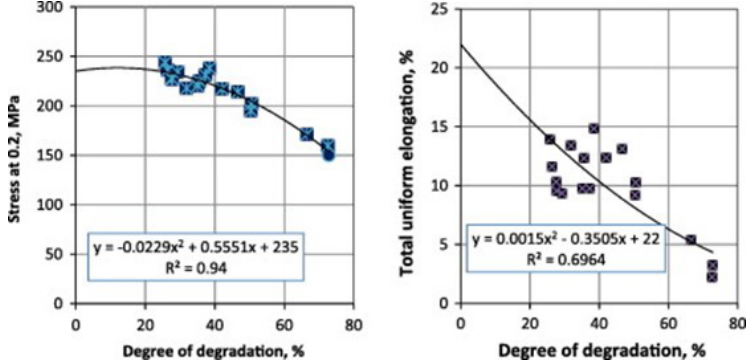
Figure 3. Mechanical properties as a function of degree of degradation